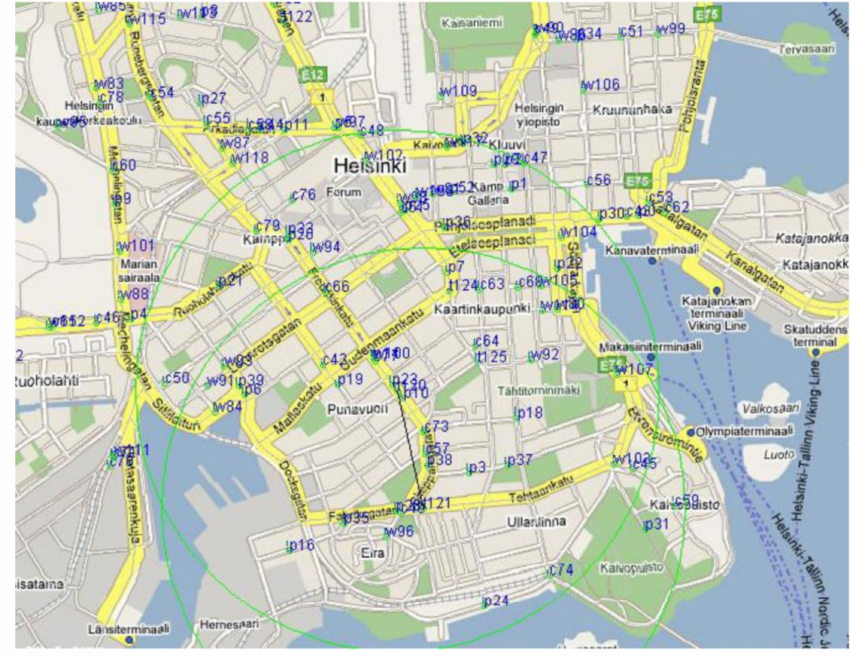
Figure 5. Simulation map in Helsinki.